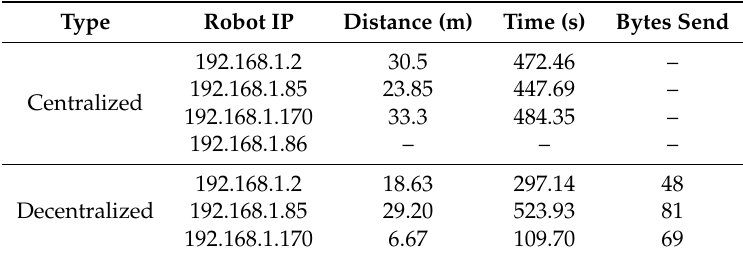
Figure 11. Topological map processed by the robot 3 agent after its failure, with the information sent from the robot 1 and robot 2 agents. Table 8. Results from the experiment with three robotic agents after the failure of the robot 3 agent.